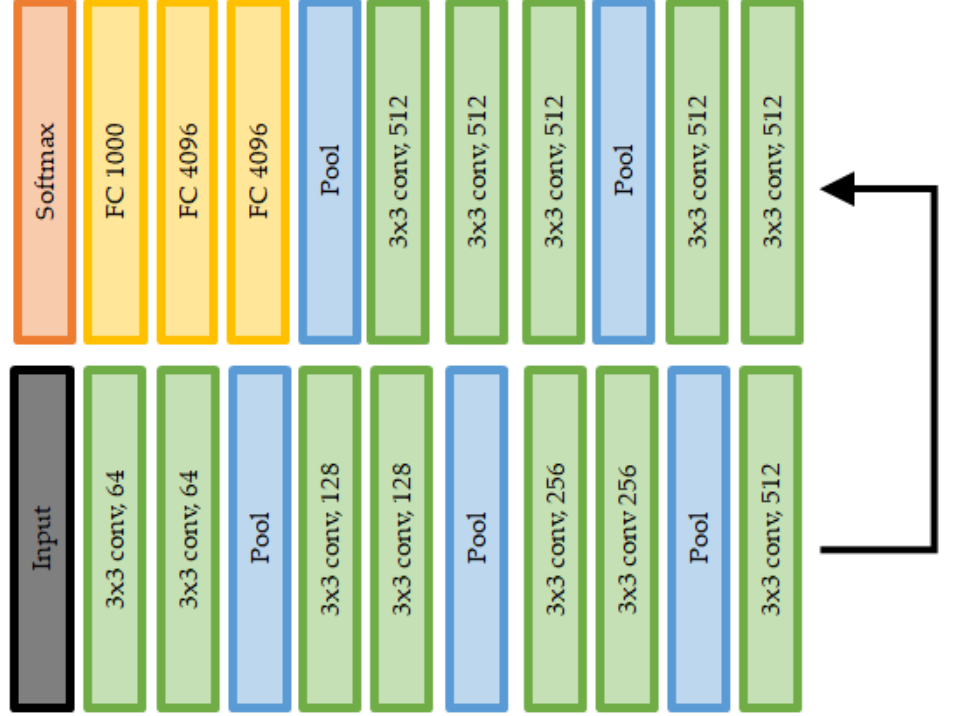
Figure 12. Basic VGG-16 structure. VGGNet is a CNN structure with a depth of 19 layers, wherein the existing CNN structure is significantly changed to improve the performance.